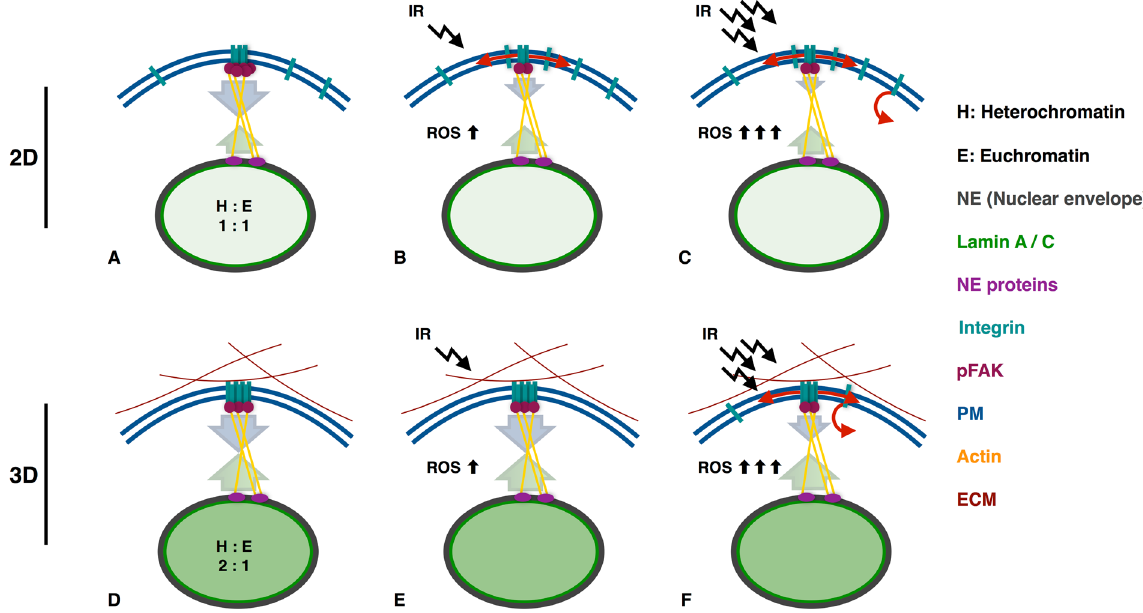
Figure 7. Mechano imbalance of 2D cells leads to their radio-sensitivity. ( A ) 2D cells show a different organisation of the nuclear matrix (Lamin A/C) and the chromatin condensation (ratio of hetero to euchromatin) if compared to 3D cells ( D ). The counterbalance of the nuclear force feedback between the integrin - cytoskeleton - nucleus link is imbalanced leading to a loose, dynamic integrin organisation in 2D cells ( A ). In 3D cells the mechanical link is well-balanced leading to firm and defined integrin clusters ( D ). An irradiation with a low dose (2 Gy) of 2D cells leads to integrin cluster disintegration by lateral diffusion and down regulation of downstream signals (pFAK) by up regulation of ROS. The imperfect force feedback combined with loose integrin clusters is responsible for the observed effects ( B ). As 3D cells exhibit a mechano- homeostasis, low doses can not effect integrin and pFAK signalling, although ROS is upregulated ( E ). ( C ) An irradiation with a high dose (15 Gy) exceeds the threshold for endocytosis leading not only to cluster disintegration by lateral diffusion but also by axial membrane transport. ( F ) 3D cells irradiated with a high dose (15 Gy) lead to a slight integrin cluster disintegration by a lateral and axial membrane transport. The equilibrium of the force feedback leads to effects that are shifted in their time dependence and in their